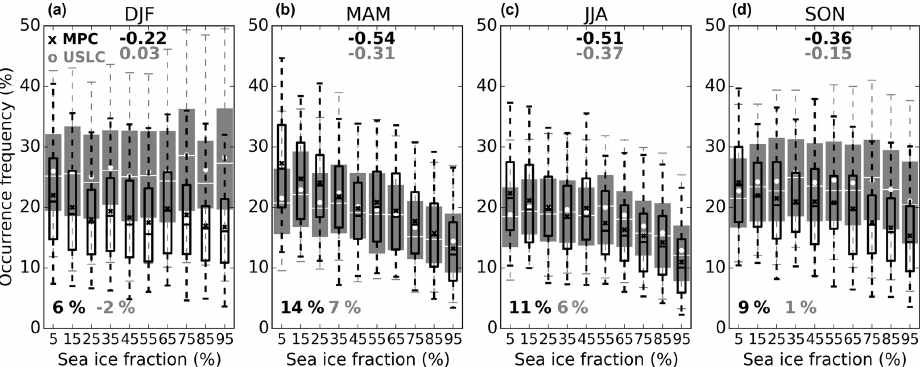
Figure 15. Same as Fig. 14 for the low-level MPC (narrow empty black boxes, with a cross showing the average) and USLC (larger shaded grey boxes, with a white circle for the average) fractions. The p values for the correlation coefficients are always < 0 . 01, except for the USLC fraction in summer ( p value = 0 .